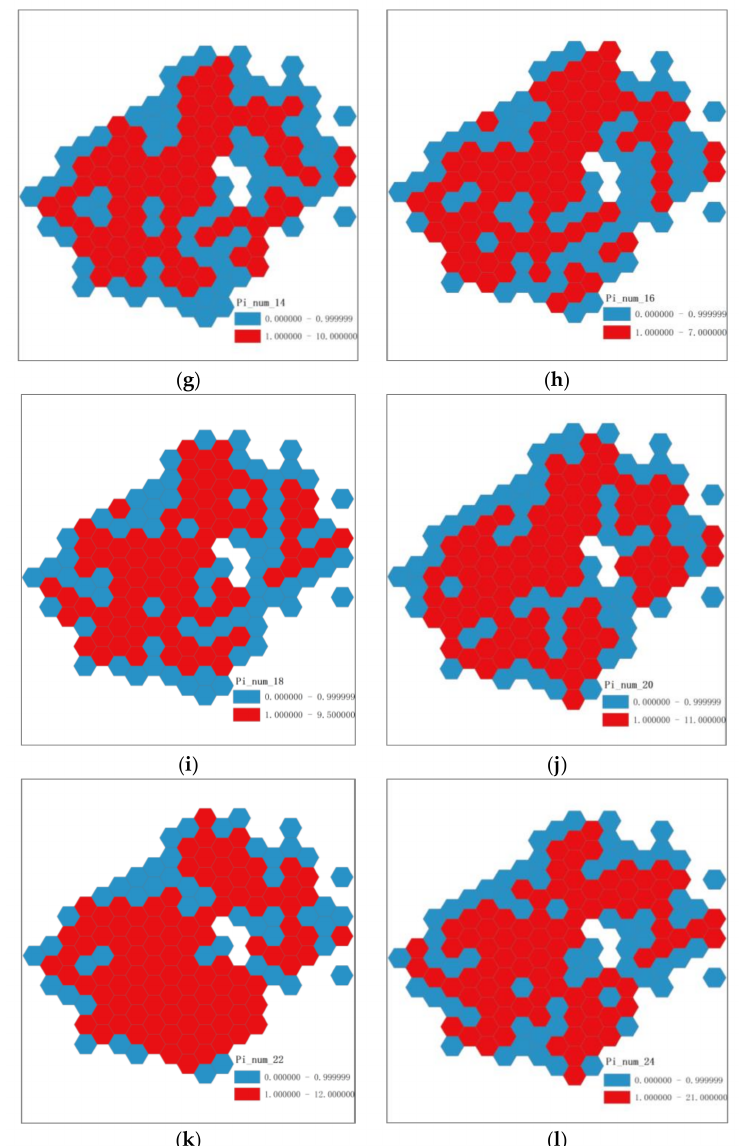
Figure 12. Hourly distribution of the inflow and outflow ratio (P i_num ) in each hexagonal grid. ( a – l ) rerepresent 12 periods spectively in a